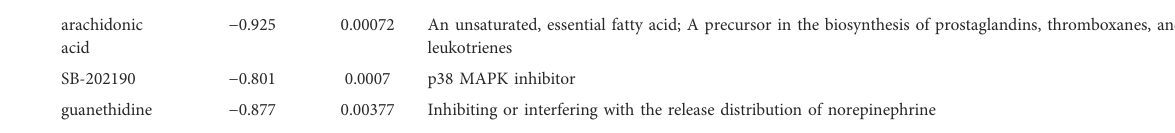
TABLE 3 Top 3 small molecules with the highest absolute enrichment values identi fi ed with risk score model DEGs. Rank Cmap name Enrichment p < 0.01